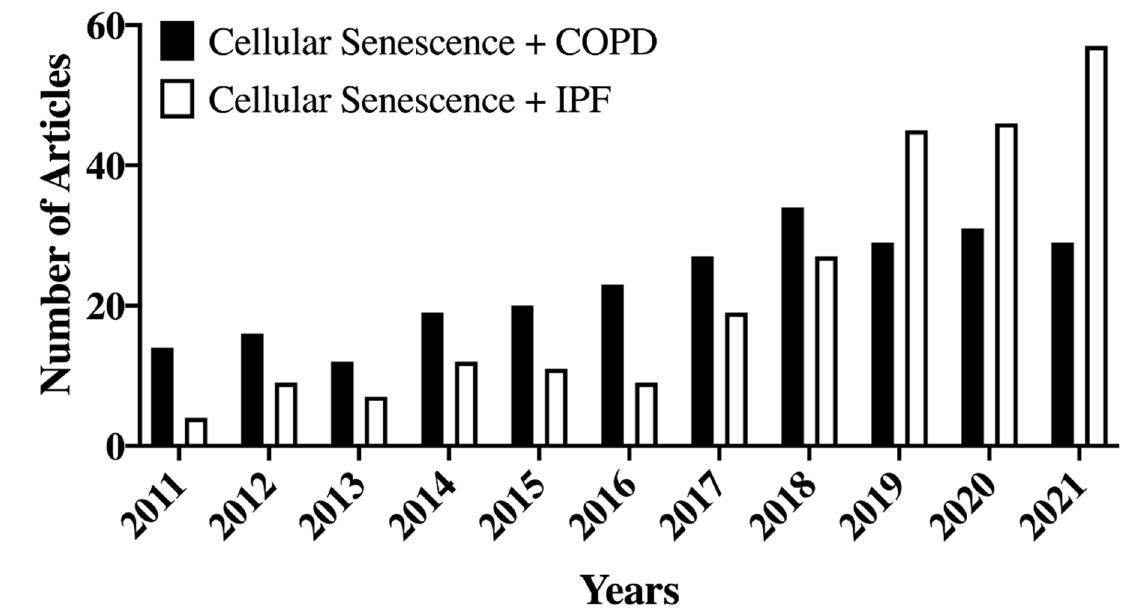
Figure 2. An increased number of articles related to Cellular Senescence and COPD or IPF have been published in PubMed-indexed journals during the past 10 years. Keywords used in PubMed search engines are “Cellular Senescence Chronic Obstructive Pulmonary Disease” or “Cellular Senescence Idiopathic Pulmonary Fibrosis”. Figure 2 was created from National Library of Medicine (https://pubmed.ncbi.nlm.nih.gov accessed on 24 April